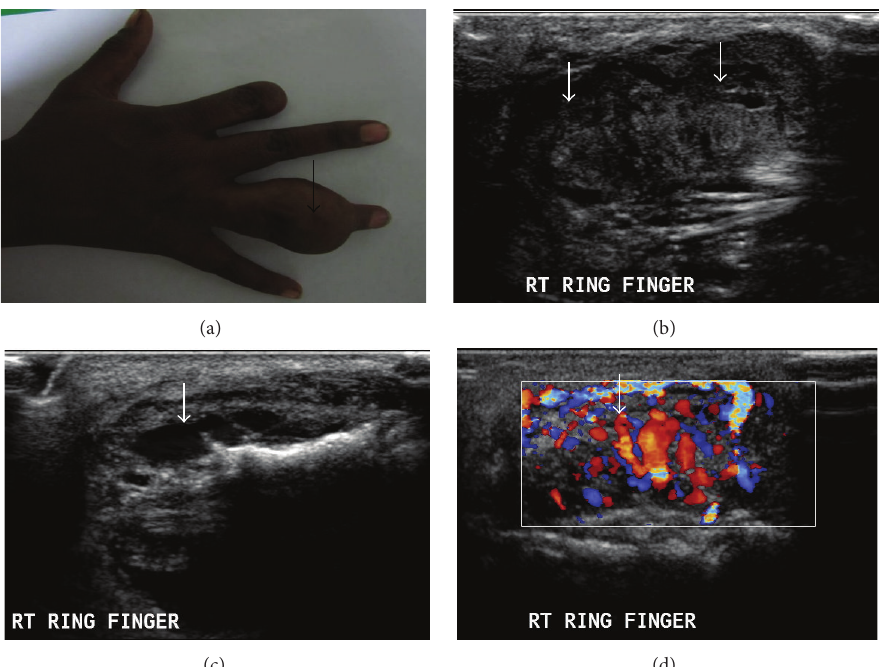
Figure 1: AVM. A 22-year-old female presented with compressible swelling involving middle phalanx of right ring finger ((a), arrow). Ultrasonography shows a heterogeneously hypoechoic lesion with multiple prominent linear hypoechoic channel (arrows) and irregularity of underlying bone ((b), (c)). Doppler showed markedly increased intralesional vascularity ((d), arrow).